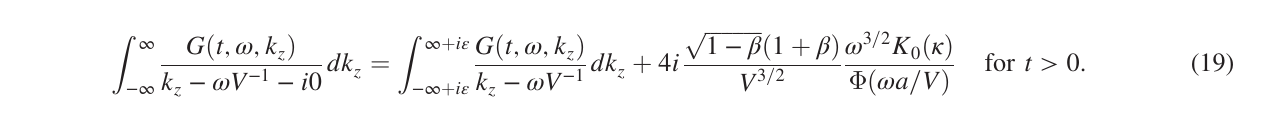
in (23) and (24) (cid:2)